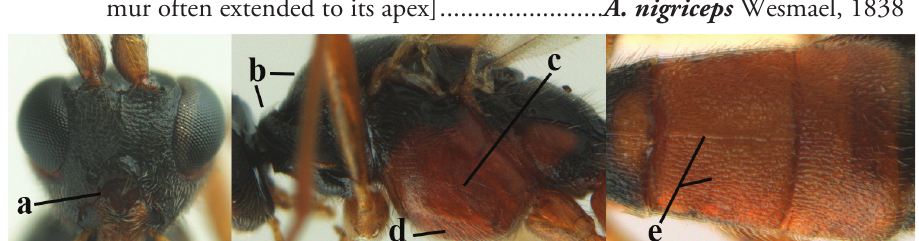
Width of hypoclypeal depression of ♀ 0.35–0.40 × minimum width of face (a); antennal segments of ♀ (38–)39–43, of ♂ (38–)39–44; mesoscutum anteriorly and pronotum medio-anteriorly usually black or dark brown (b); medially mesopleuron usually without distinct rugulae or with a few (c); mesosternum yellowish, orange-brown or reddish (d), if darkened then not sharply defined; second metasomal tergite of ♀ with well differentiated me- dian carina (e); lateral margins of third and fourth metasomal tergites of ♂ often completely yellowish, but sometimes darkened; [dark part of hind